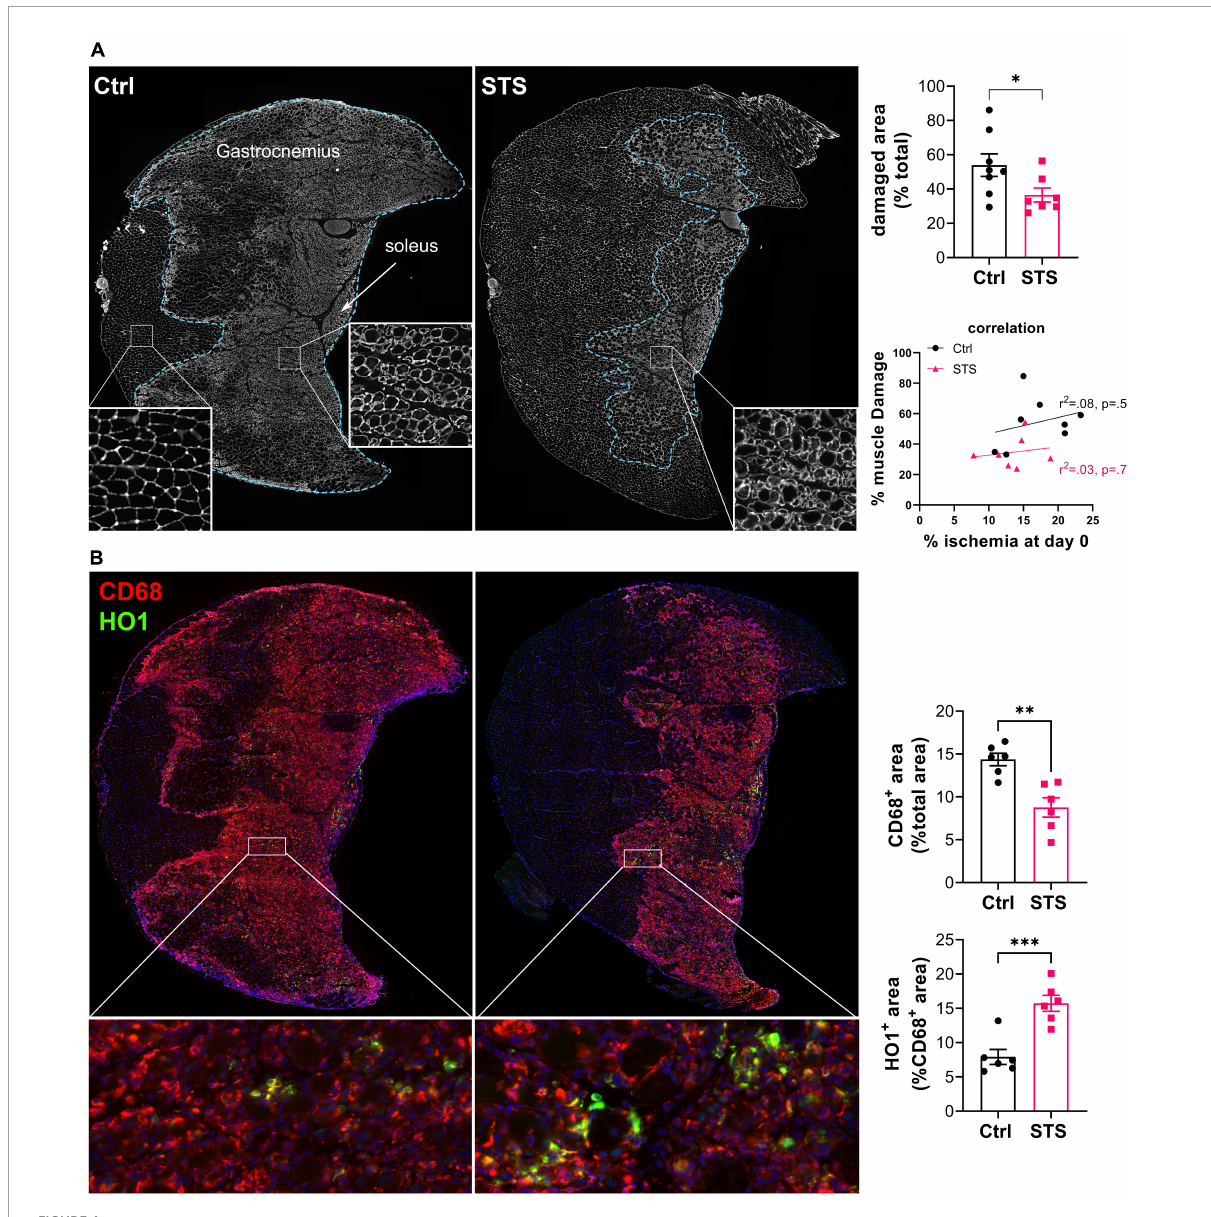
FIGURE4 Sodium thiosulfate (STS) limits inflammation and muscle damage 4 days after ischemia. (A) Left panel : Representative images of gastrocnemius and soleus muscle of WT mice treated or not (Ctrl) with 4 g/L STS, stained for laminin (white). Damaged area delimited by the blue dotted line. Right upper panel : Quantification of the damaged area, expressed as a percentage of the total muscle area. Data are mean ± SEM. * p < 0.05 as determined by unpaired t -test. Right lower panel : correlation between muscle damage and ischemia after the surgery. Data analyzed by Pearson correlation. (B) Left panel: Representative images of gastrocnemius and soleus muscle of WT mice treated or not (Ctrl) with 2 g/L STS, stained for CD68 (red) and HO1 (green). Right panel : CD68 and HO1 positive area quantification. Data are mean ± SEM. ** p < 0.01 *** p < 0.001 as determined by bilateral unpaired t